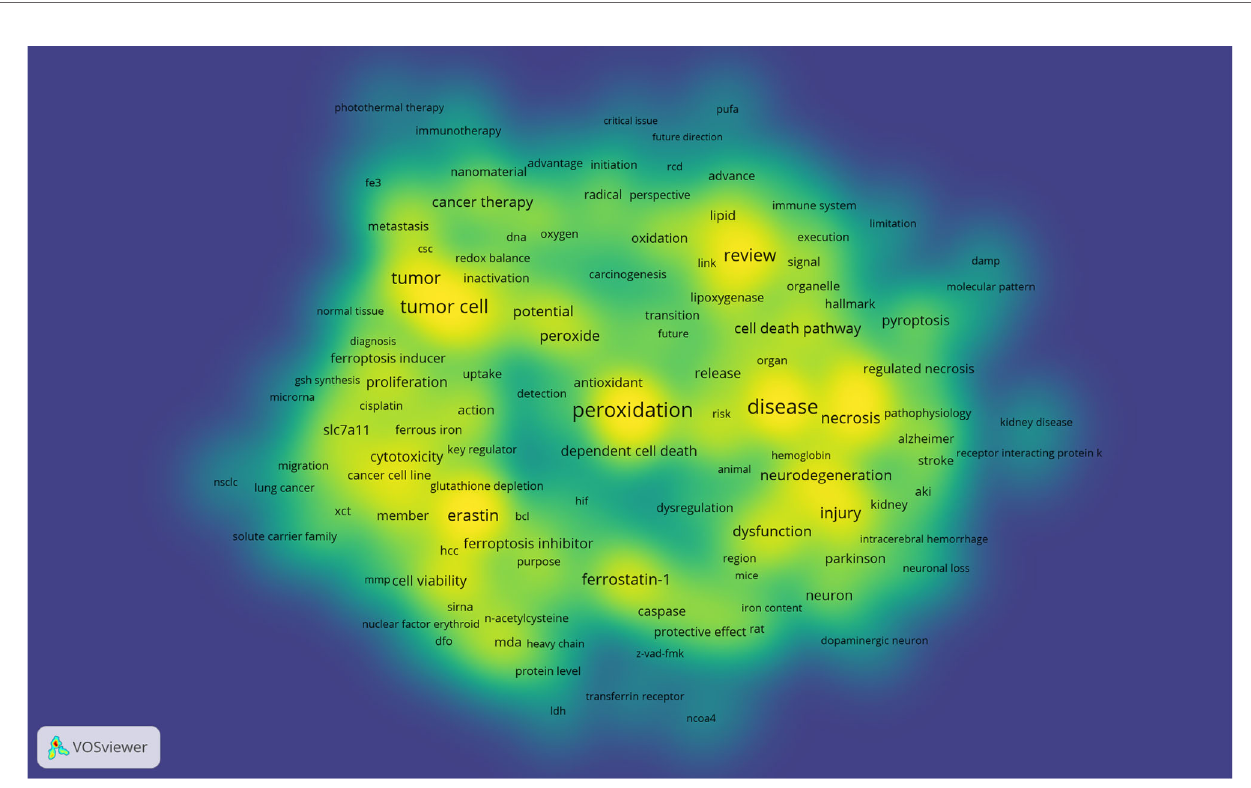
FIGURE 6 | The density map of terms in ferroptosis research (T ≥ 10, relevance score ≥ 0.081) Notes: The size of word, the size of round, and the opacity of yellow is positively related to the co-occurrence